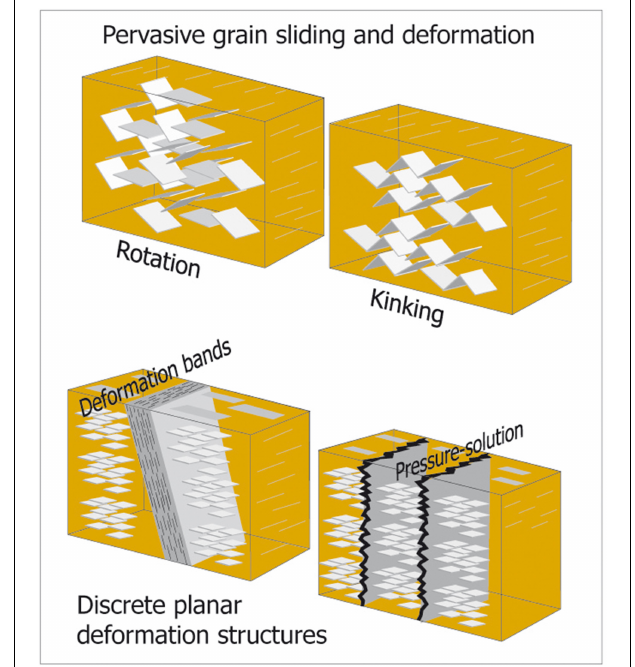
FIGURE 9 | Summary of possible deformation mechanisms that can produce tectonic magnetic fabrics in